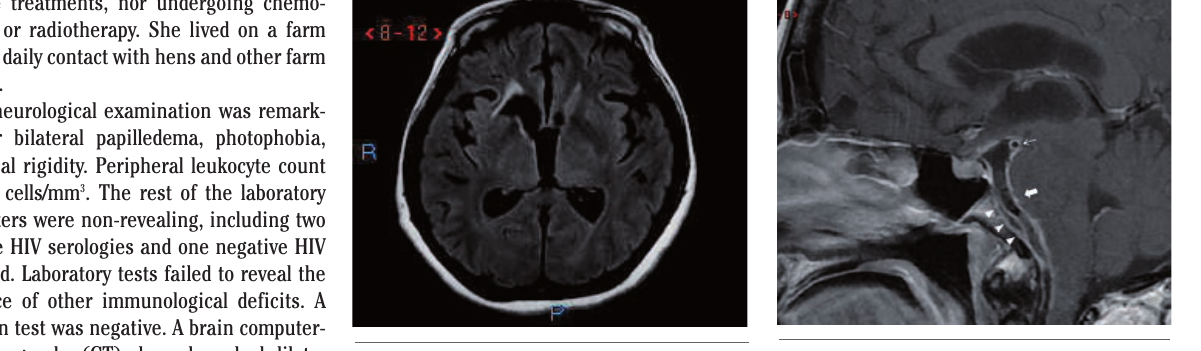
Figure 2. T1 Sagital MRI with gadolinium showing ventricular dilatation, basal arachnoiditis, (thick arrow) perivascular enhancement (thin arrow) and a dural col- lection dorsal to the clivus (arrow heads).